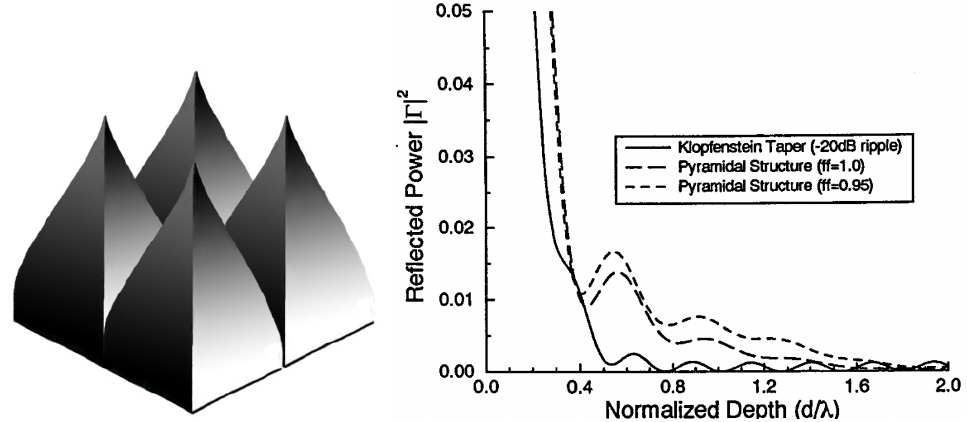
Figure 22. Klopfenstein structures have much better AR properties at shorter heights than do pyramids. Klopfenstein structures are shown on the ( left ), and the RCWA-calculated reflectivity vs . normalized depth for Klopfenstein and pyramid structures is shown on the ( right ). Right side reprinted with permission from reference [97], Copyright 1995 Optical Society of America.